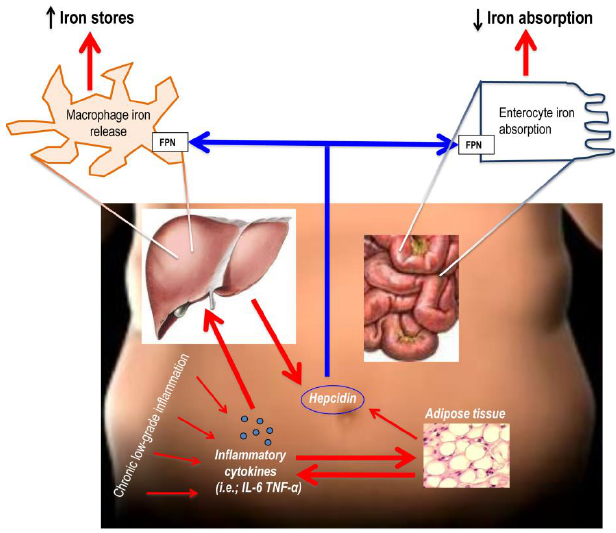
Figure 2. The role of hepcidin in the connection between adiposity and poor iron status. Several researchers have demonstrated that serum hepcidin is significantly elevated in obese compared to lean women and children [14,32]. One study reported that overweight children have higher circulating hepcidin and poorer iron status, despite similar dietary iron intake, when compared to normal weight children [14]. In another study, overweight children were found to have